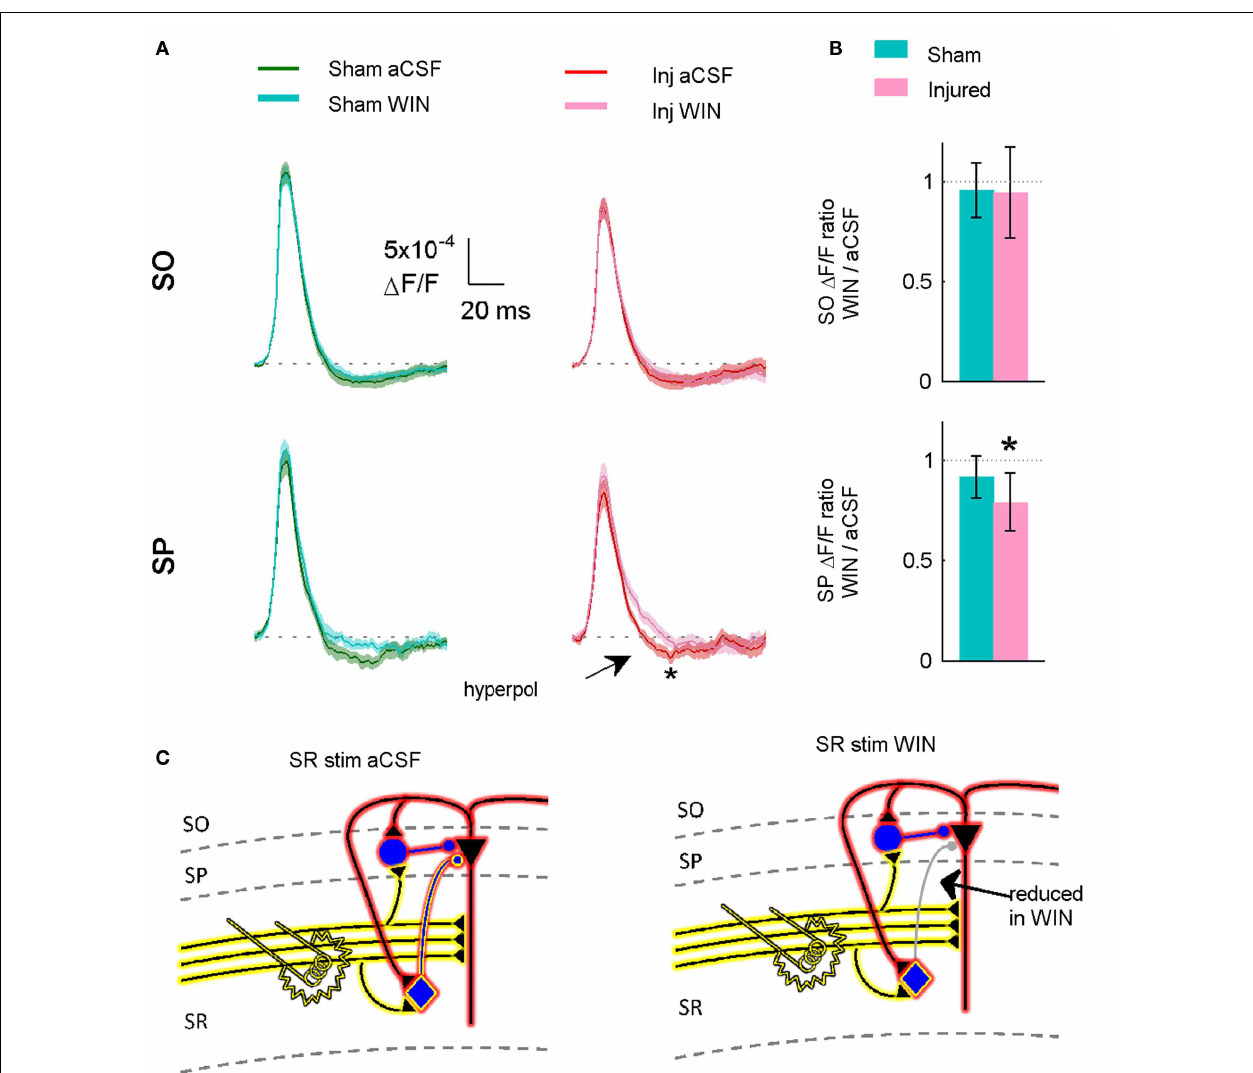
SR-evoked SP hyperpolarization in both sham and injured slices, the difference was only significant for injured animals (sham P = 0.226, injured P = 0.032). Stimulus 500 µ A, analysis region 1100–1400 µ m. (B) Group average WIN55,212-2 effect. Ratio of response inWIN55212-2 to response in aCSF. The relative magnitude of theWIN effect is significantly different from unity in the slices from injured animals (signed rank P values for test of median = 1: sham P = 0.424, injured P = 0.042). Dotted line indicatesWIN/aCSF ratio equal to unity. (C) Schematic showing reduction of synaptic transmission from CCK positive basket cell to pyramidal neuron